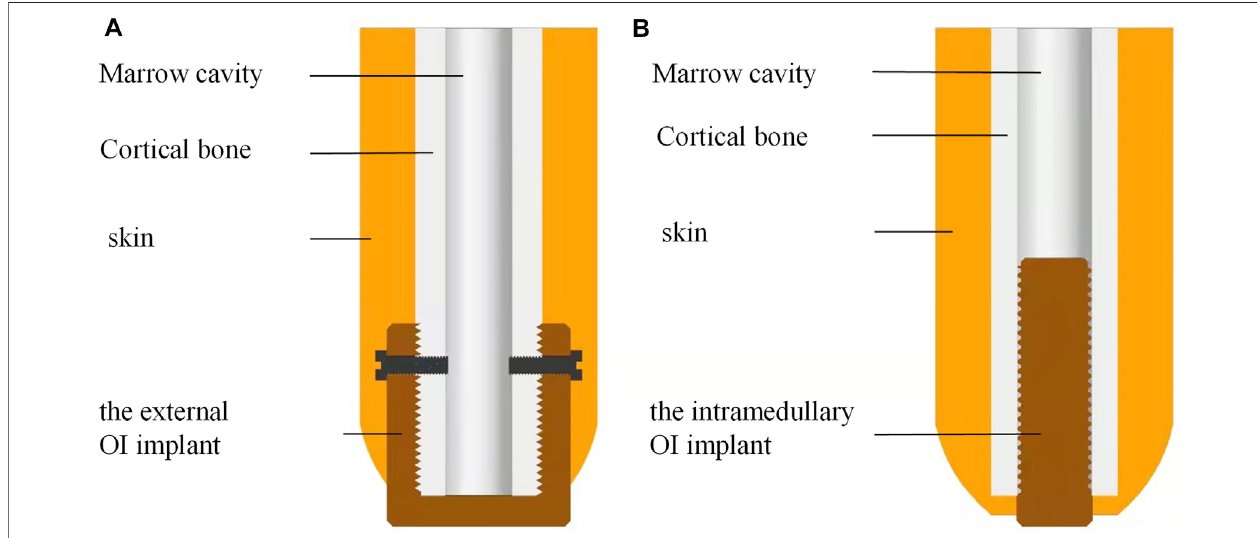
FIGURE 1 | A schematic diagram of the novel external cap implant and the internal columnar implant. (A) Novel design of the extramedullary cap-shaped OI implant; (B) Current design of the intramedullary implanted columnar implant.